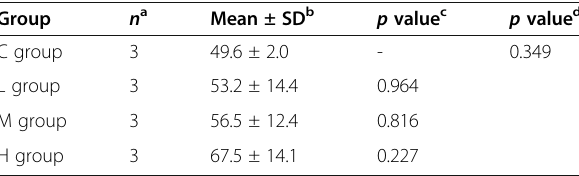
Table 2 Average thickness of the bronchial smooth